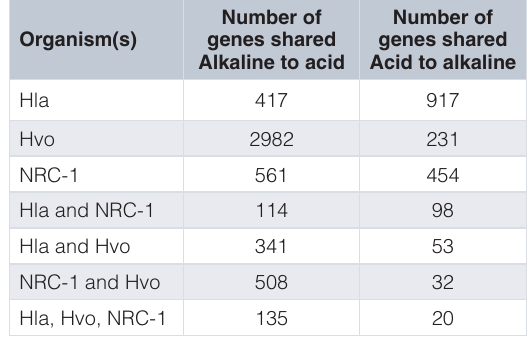
Table 3. Transcripts regulated under shift from pH